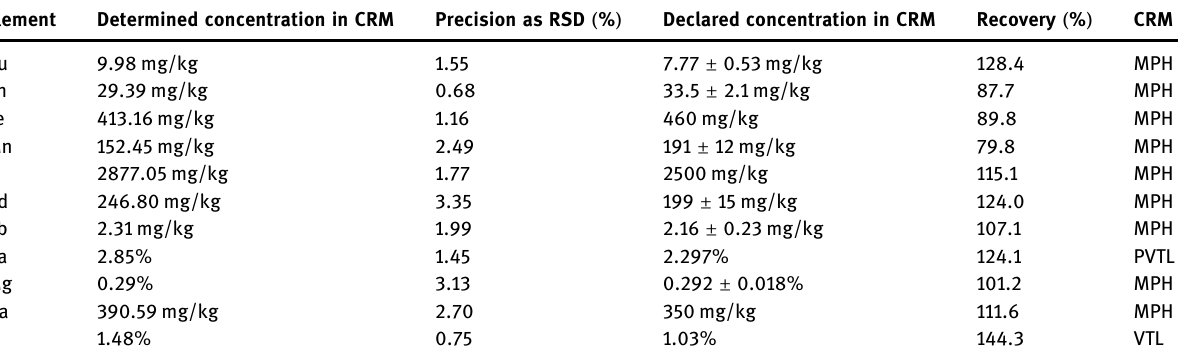
Table 2: Statistical evaluation of results obtained for metallic elements in CRMs by AAS Element Determined concentration in